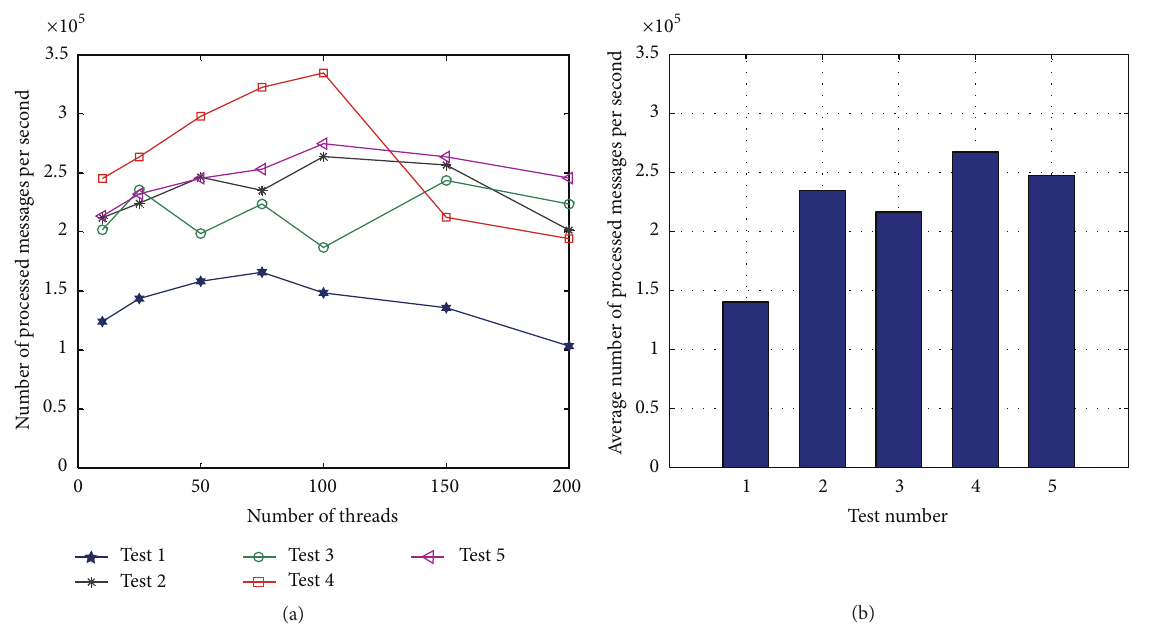
Figure 18: The performance of the X73 uHealth cloud: (a) the number of processed messages per second in each test for different threads; (b) the average number of processed messages per second for different tests.